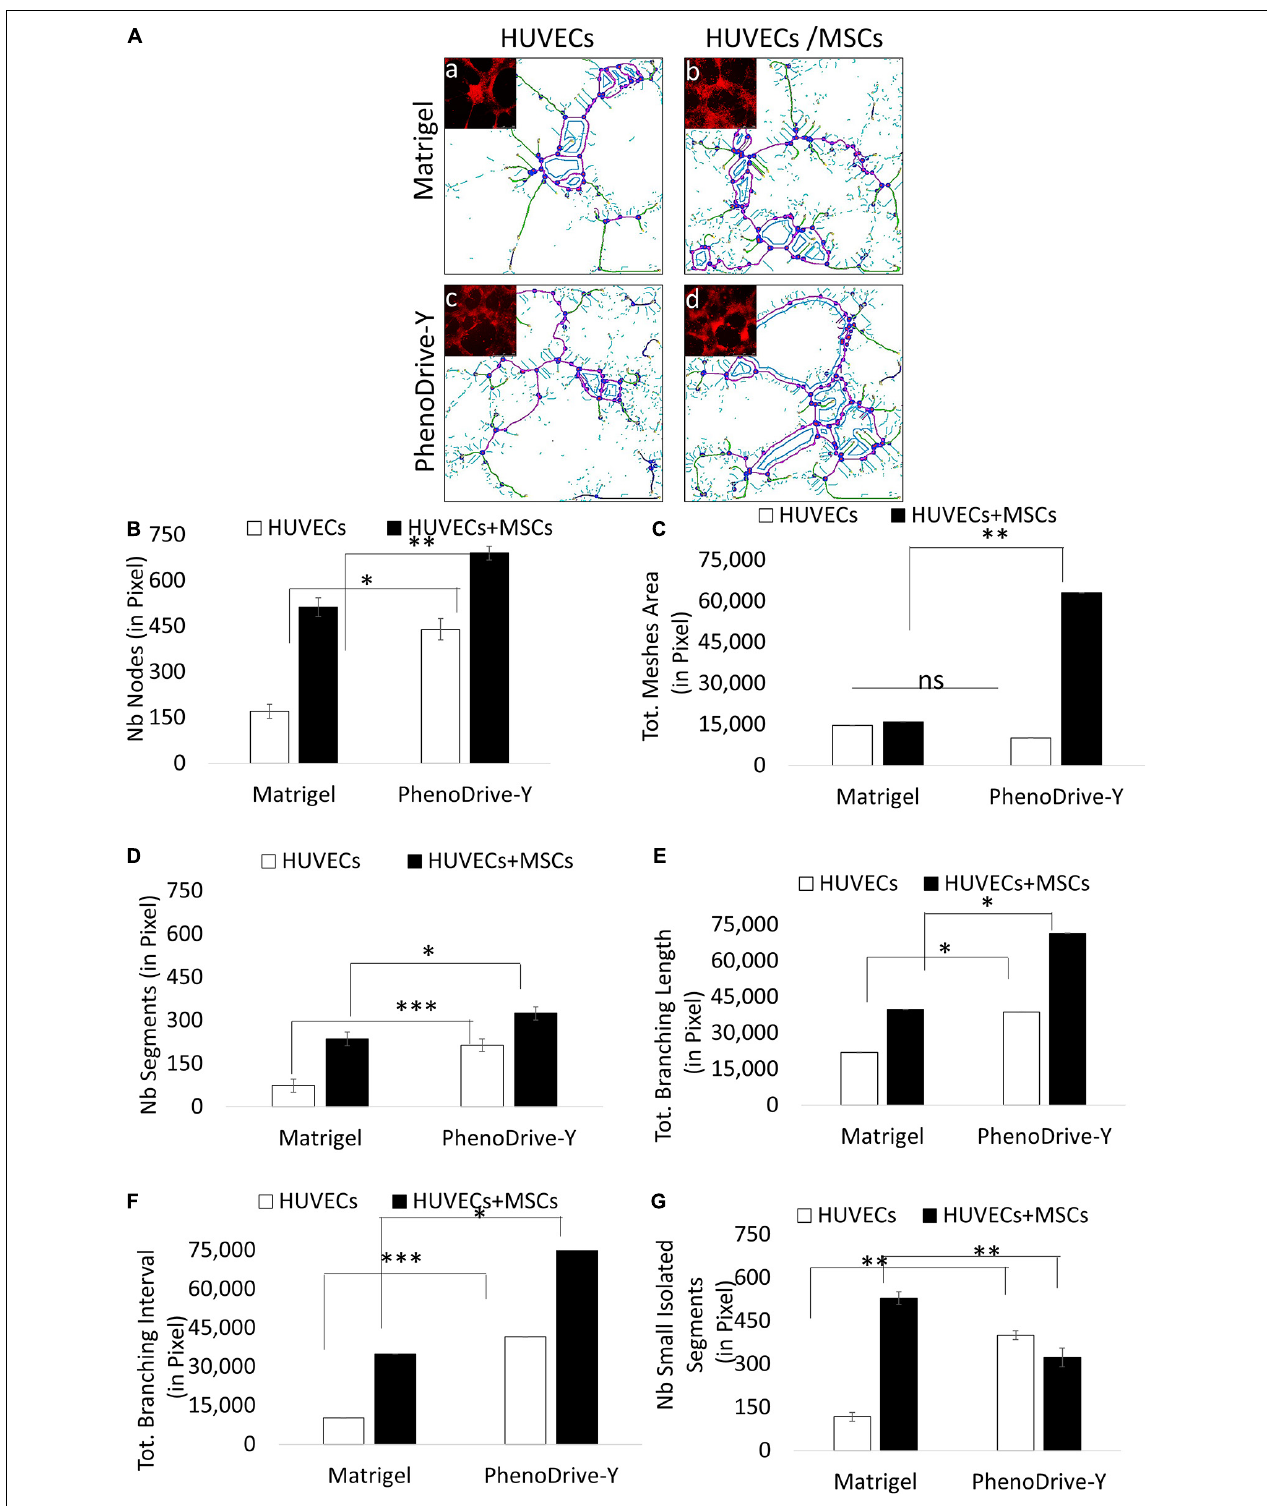
FIGURE 3 | Morphometric analysis of the capillary-like human umbilical vascular endothelial cell (HUVEC) tubules at 48 h. (A) Microscopic images analyzed using ImageJ software with the Angiogenesis Analyzer plug-in and identified as nodes in red circled blue , segments in magenta , small isolated segments in cyan , meshes in blue , and branches in green . (B–F) Average number (Nb) of nodes (B) , mesh area (C) , segments (D) , branching length (E) , branching interval (F) , and small isolated segments (G) . ∗ p ≤ 0.01, ∗∗ p ≤ 0.001, ∗∗∗ p < 0.0001 ( ± SD; n = 9). ( a – d ) Phalloidin–rhodamine staining ( red ) Scale bar , 500 µ m.